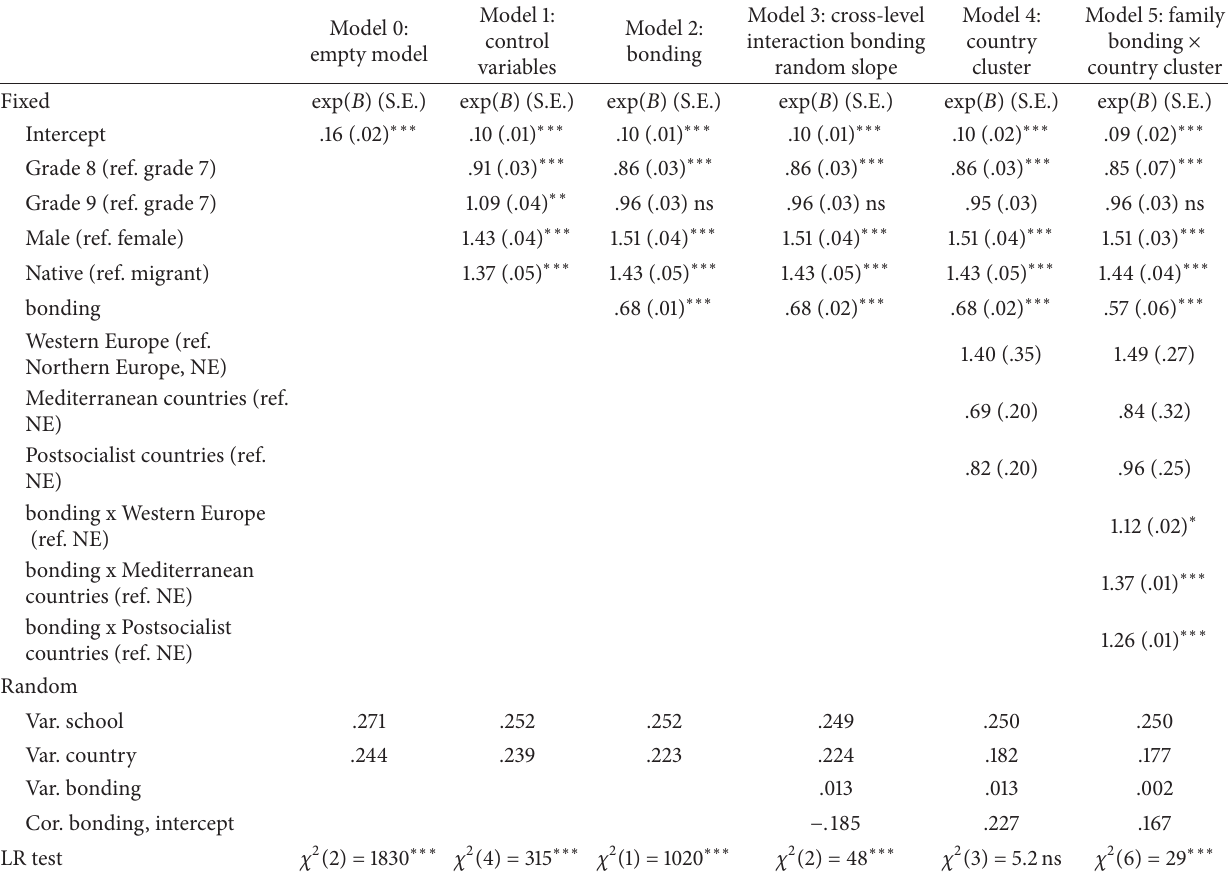
Table 4: The results of multilevel analysis concerning bonding (last model: 𝑛 individuals 52724; 𝑛 schools 1344; 𝑛 countries: